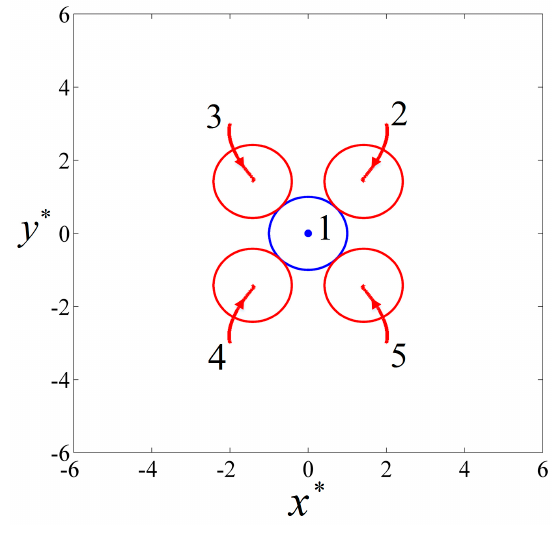
Figure 5. The particle trajectories and the final positions of five particles in a perpendicular AC field with (cid:101) E 0 = 0.02 and f = 10 3 Hz. The blue and red colors denote pDEP and nDEP particles, respectively. The variations of the DEP interactive forces of particle 1 and particle 2 with time are shown in Figure 6, where the blue color denotes particle 1 and the red color denotes particle 2. It can be seen that the force of particle 1 was zero all the time due to the symmetrical distribution of the other four particles, which is consistent with Figure 5, while the force of particle 2 increased rapidly with time and finally reached a constant value when particle 2 came into contact with particle 1. The DEP interactive forces of particles 3, 4, and 5 are similar to particle 2 and will not be